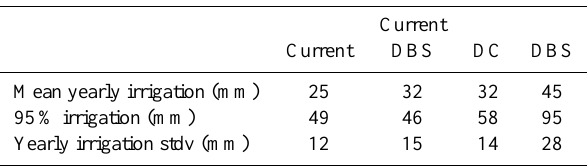
Table 5. Irrigation indicators for the current scenario and the future scenario using both DC and DBS bias correction.